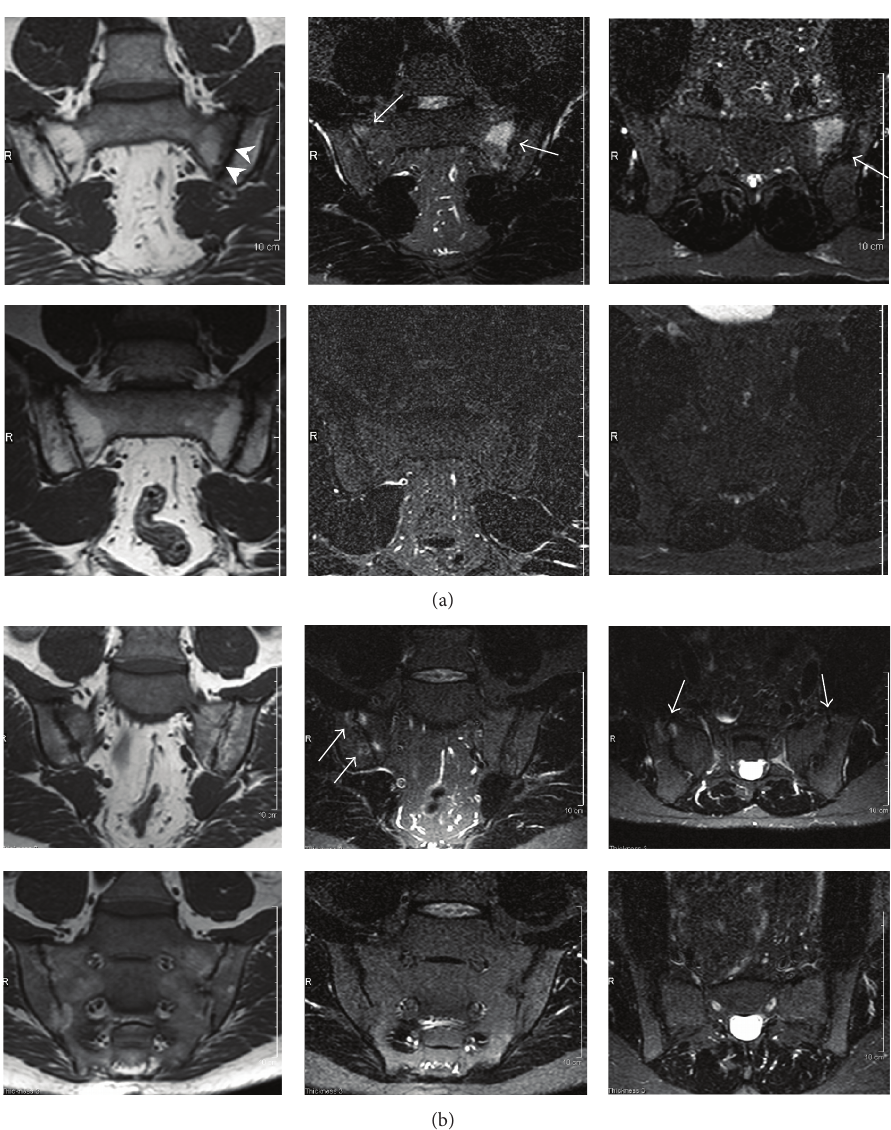
Figure 4: (a) A representative MRI study at inclusion (top row) with bilateral inflammatory changes (arrows). There is a 2 × 3 cm high signal intensity lesion on the sacral side of the left sacroiliac joint on the STIR images (coronal and axial) with corresponding low signal intensity on the coronal T1-weighted image. At the right sacroiliac joint, there are smaller and more subtle lesions on both sides of the joint. There are sclerotic changes along the left joint (arrowheads). At 16 weeks (bottom row), no oedematous lesions can be seen. (b) An MRI study showing bilateral sacroiliitis in an AS patient at inclusion and at 16 weeks. At inclusion, there are bilateral inflammatory changes on the MRI images (top row, arrows). At the right sacroiliac joint, there is a 1 × 1 cm high signal intensity lesion in the sacrum on the STIR images (coronal and axial) with corresponding low signal intensity on the coronal T1-weighted image. On the left, there are smaller and more subtle lesions on both sides of the joint. There are sclerotic changes along the right sacroiliac joint. At 16 weeks (bottom row), no oedematous lesions can be